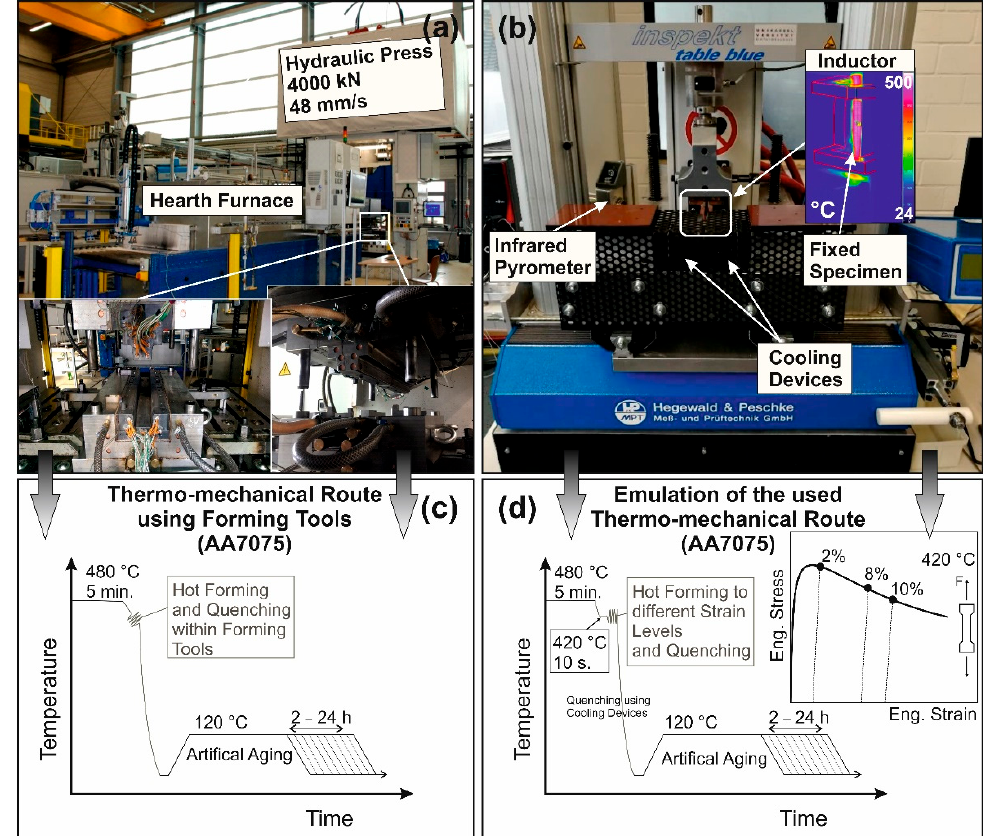
Figure 1. Selected experimental setups: ( a ) roller hearth furnace and press with forming tool, ( b ) tensile machine equipped with heating and cooling devices to emulate the thermo-mechanical process, and ( c , d ) schematic illustration of process routes and corresponding process parameters. Adapted from [31]. In ( c ), the process parameters of the thermo-mechanical forming and subsequent aging are shown. After solution treatment, the sheet material is hot-formed and quenched within the forming tools. In ( d ), the selected parameters for the emulated forming process are illustrated. The heated material is cooled to the forming temperature of 420 °C after solution treatment and is then held for 10 s to obtain a homogenous temperature to emulate the heat losses during the sheet transfer and tool closure. Immediately after completion of the controlled hot deformation ranging from 2 to 10% at 420 °C, the specimen is quenched using cooling devices.